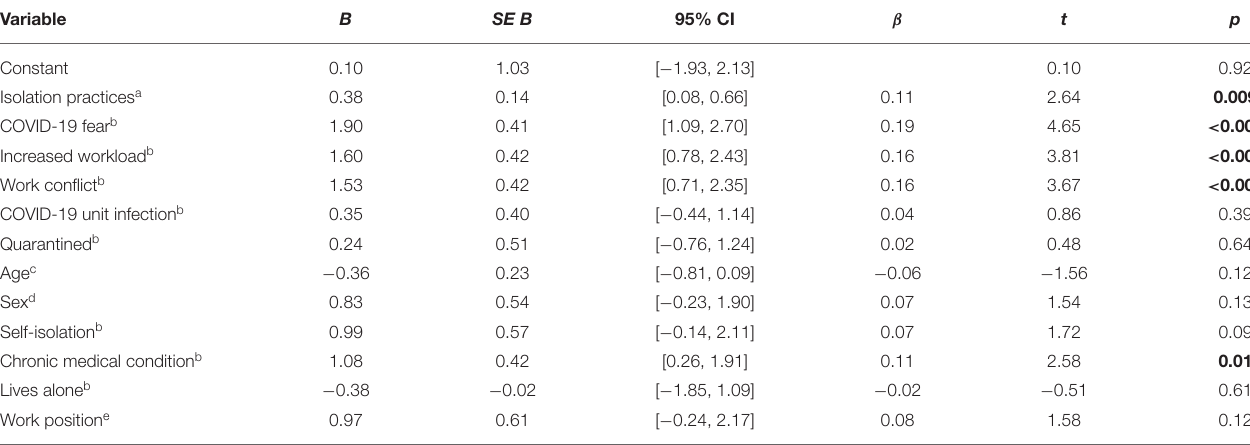
TABLE 10 | Multiple linear regression analysis for worker variables predicting IES-R posttraumatic stress—hyperarousal score. Variable B SE B 95% CI β Constant